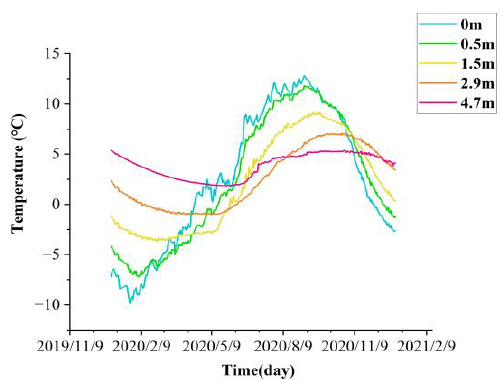
Figure 2. Study section layout.